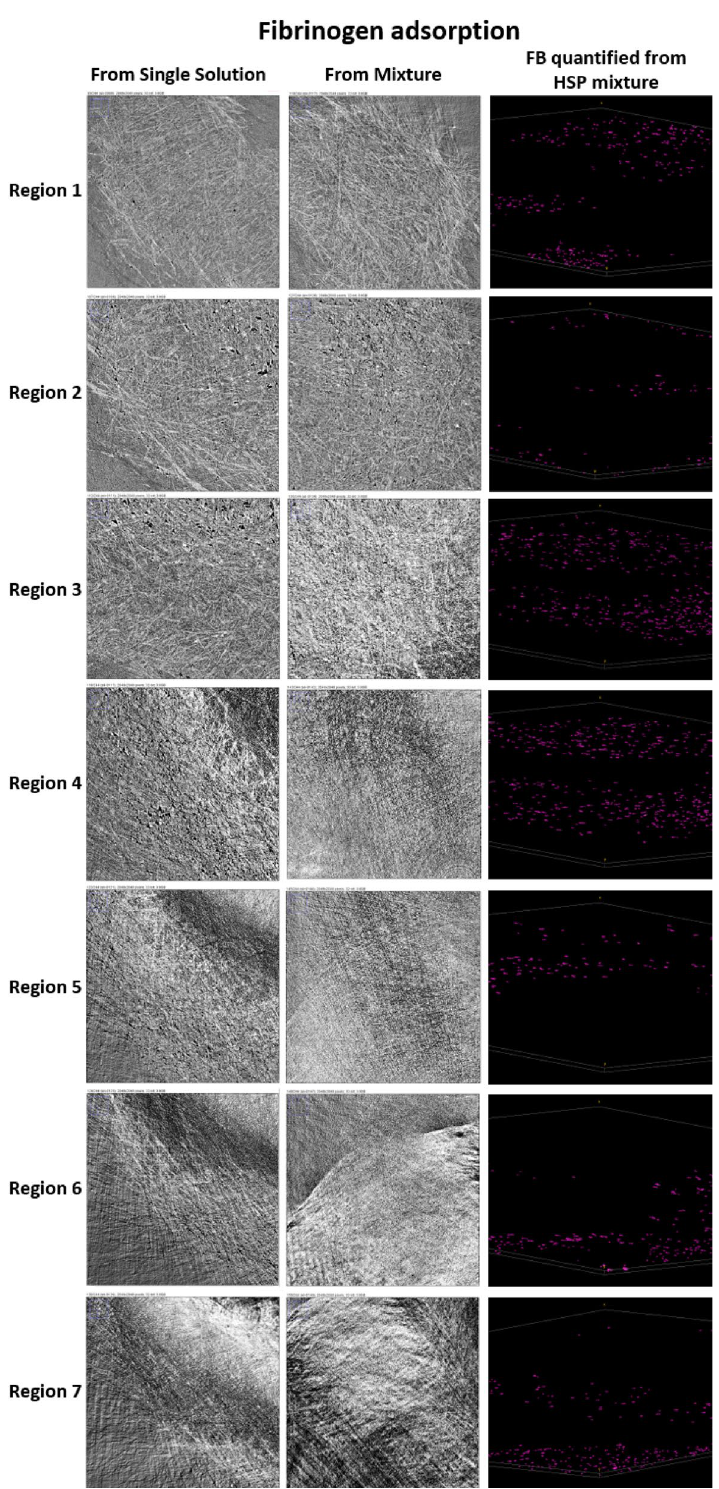
Figure 7. Converted radiographs of PES membrane with adsorbed FB from its single solution and HSP, and the visualization of the FB distribution across the membrane